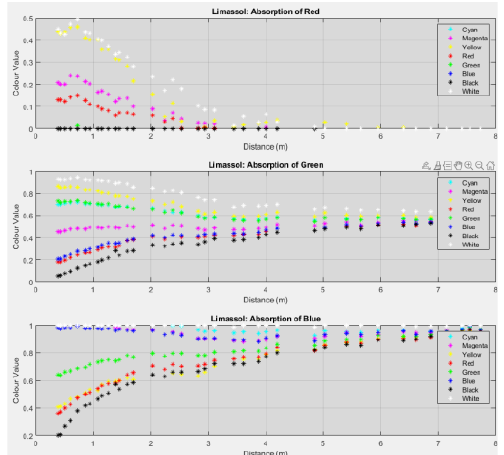
Figure 3. The diagram shows the value of the intensity absorption of Red, Green and Blue colour channels (top to bottom), for each of the eight main colour patches (Red, Green, Blue, Cyan, Magenta, Yellow, Black, White), based on camera to object distances for Limassol test